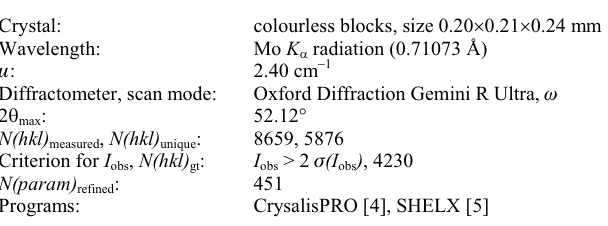
Table 1. Data collection and handling.